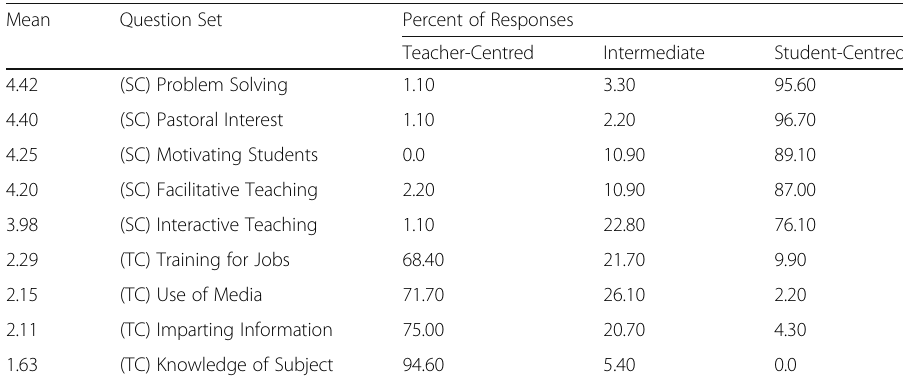
Table 3 Conception of teaching responses